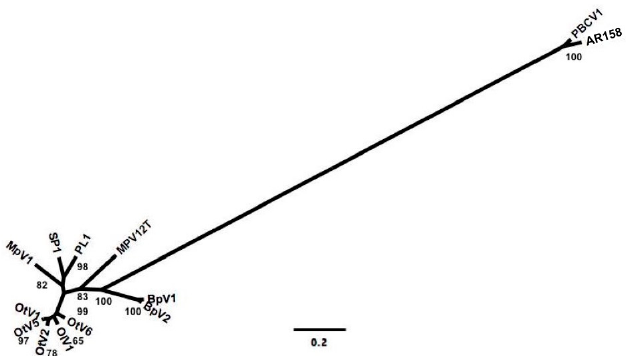
Figure 4. Maximum likelihood tree of prasinoviruses and chloroviruses infecting the genera